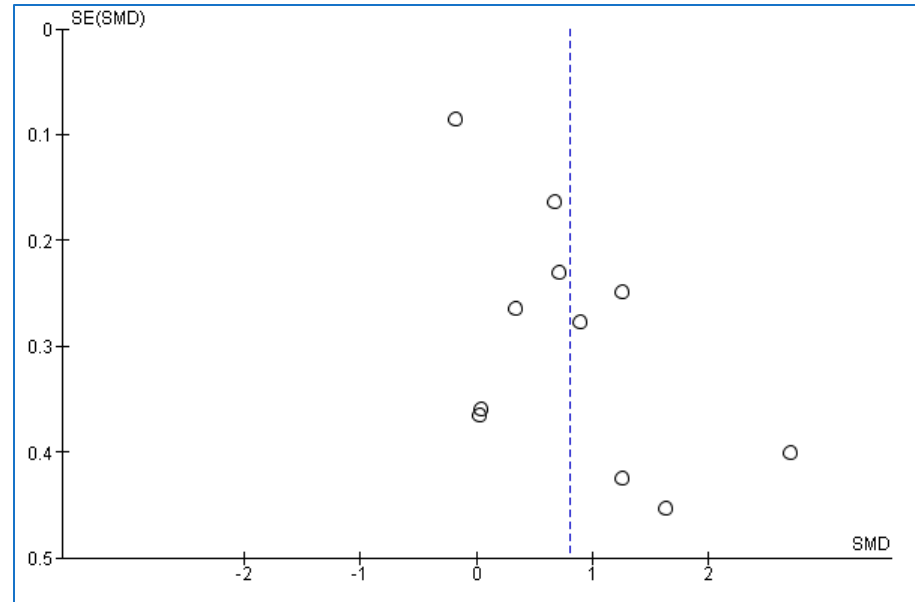
Figure 4. Funnel plot in adults with obstructive sleep apnea compared to controls. SMD: Standardized mean difference. SE: Standard error. Each small circle of the plot represents a separate one study. The vertical dotted line indicates the overall effect from the meta-analysis.